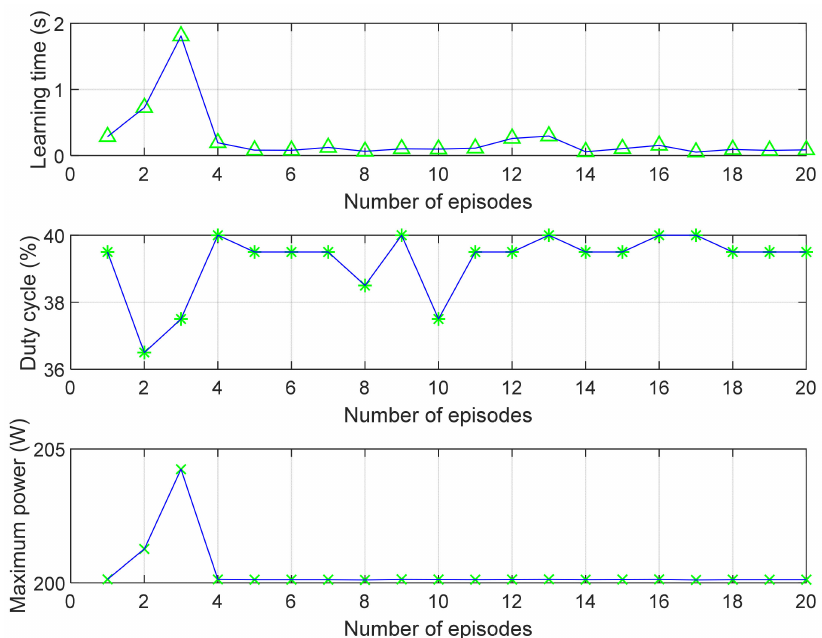
Figure 18. Q-learning MPPT training based on the standard test conditions (G = 1000 W / m 2 and T = 25 ◦ C).